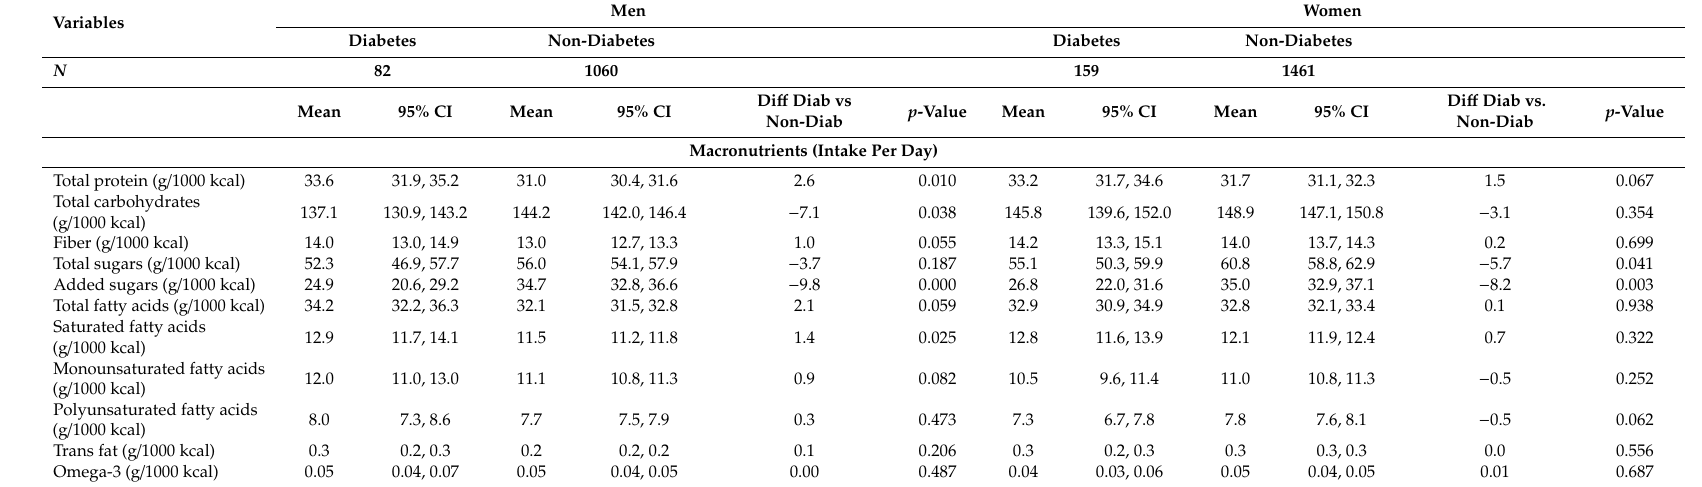
Table 4. Sex-stratified adjusted intakes of macronutrients in Mexican adults by diabetes status ( n = 2762) a . Men Women Variables Diabetes Non-Diabetes Diabetes